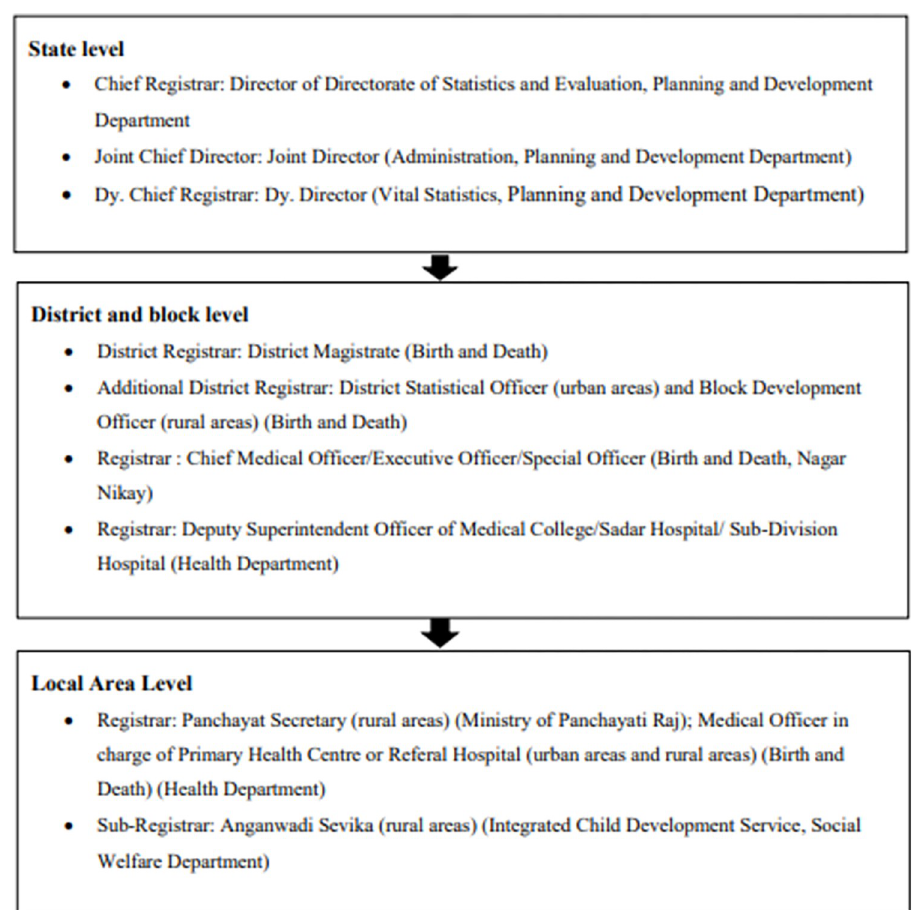
Fig 3. Hierarchy of Civil Registration System in Bihar. Source- CRS annual report, 2020. Department of Planning and Development, Bihar, 2021.